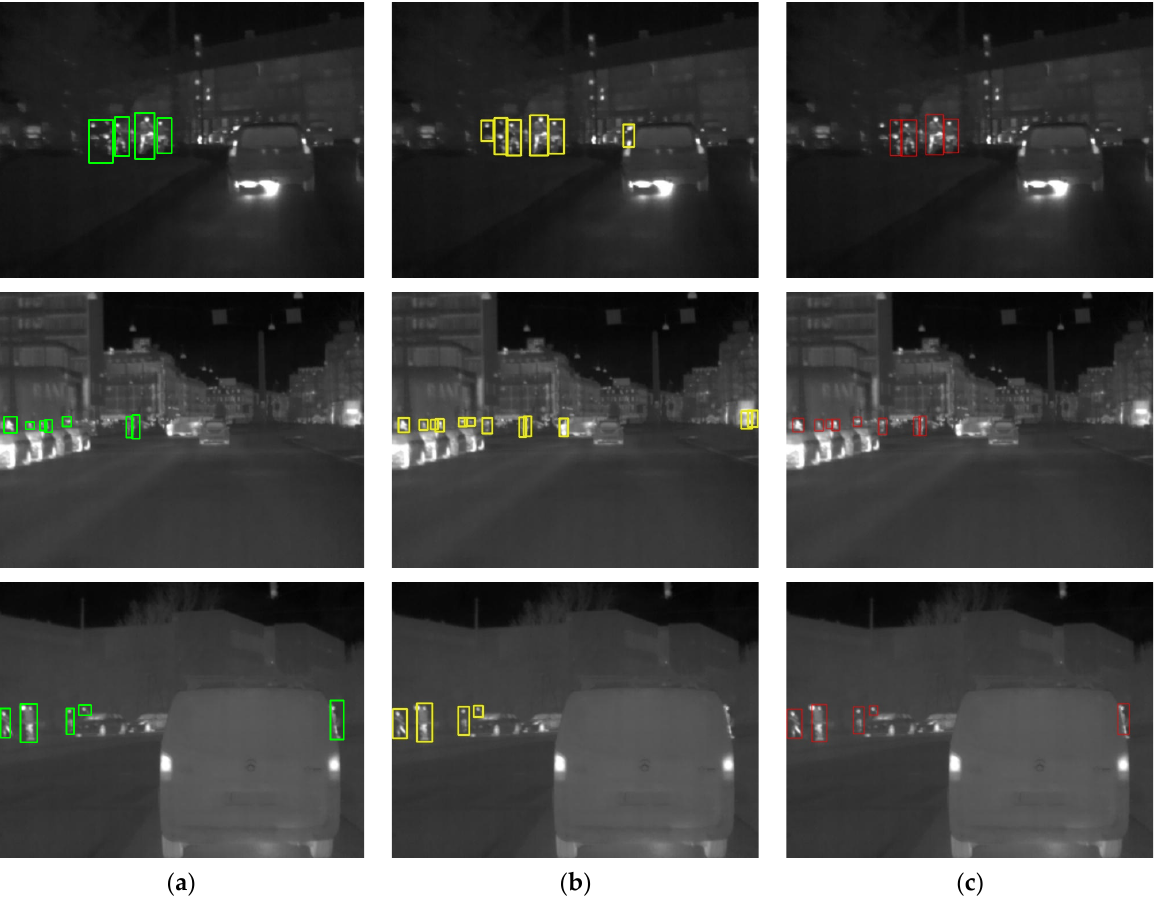
Figure 12. Infrared pedestrian detection instance, where the green boxes represent the pedestrians annotated in the dataset, the yellow boxes represent the detection results inferred by YOLOv5s, and the red boxes represent the detection results inferred by IPD-Net: ( a ) Infrared image with annotation; ( b ) YOLOv5s detection results; ( c ) IPD-Net detection results.